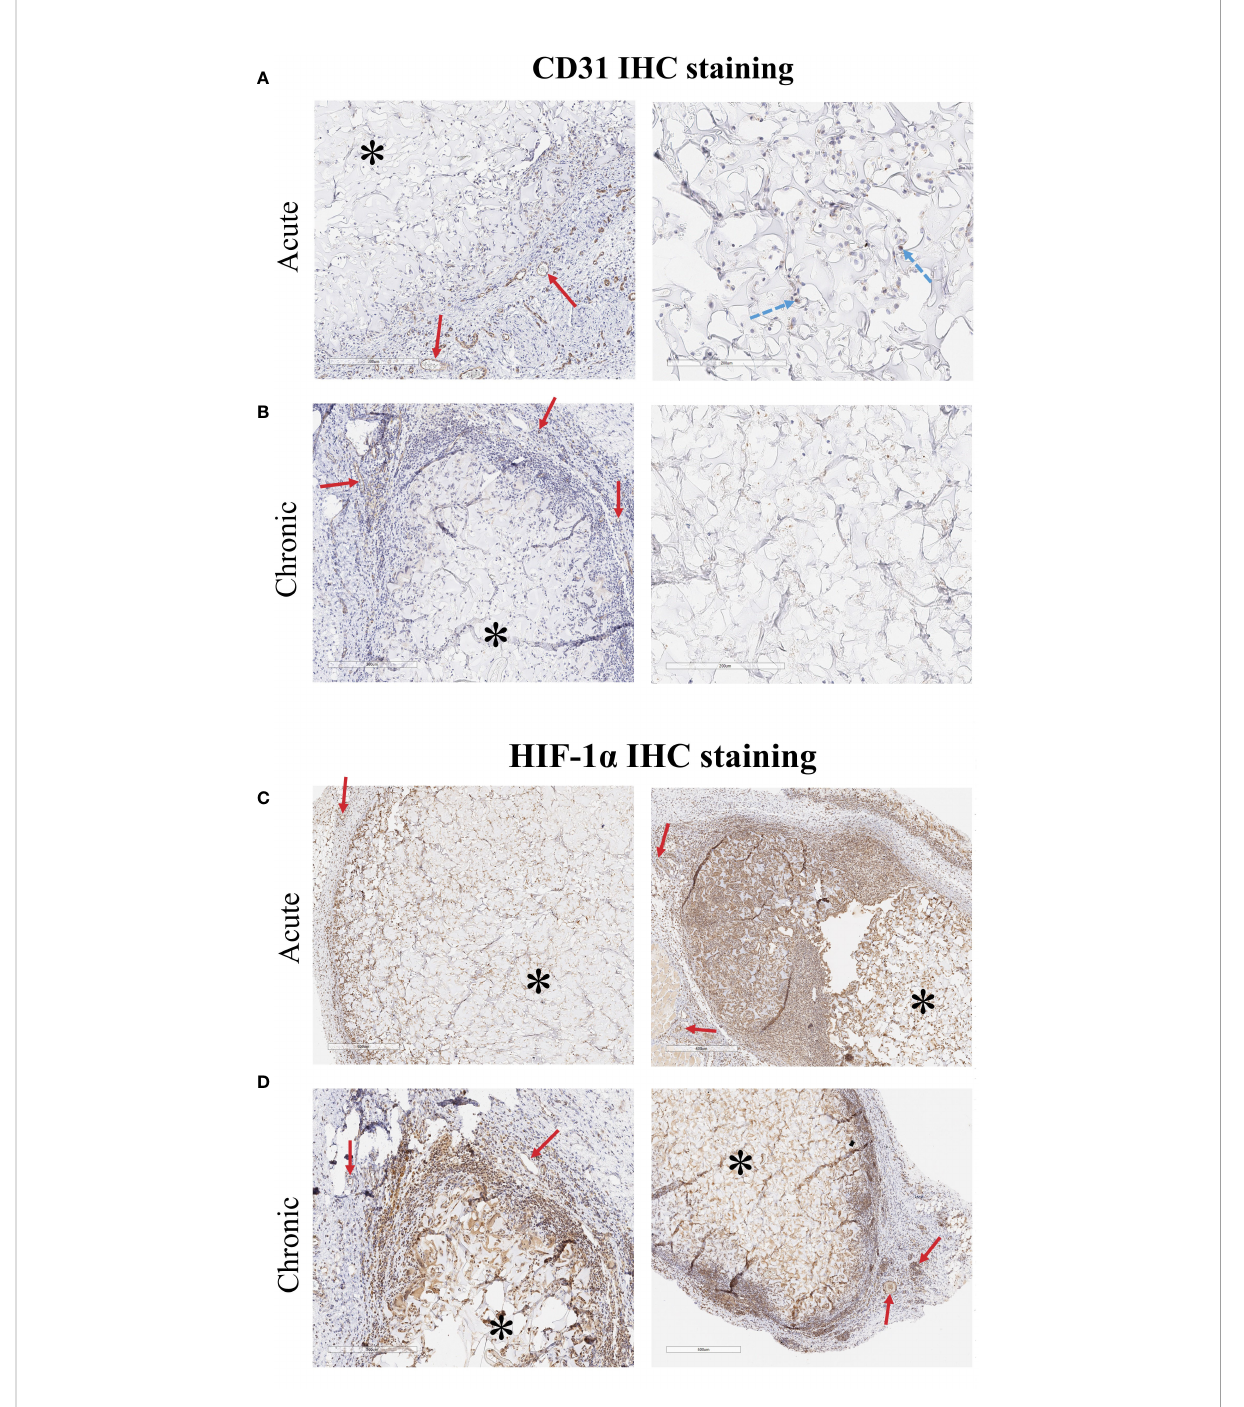
FIGURE 7 CD31 IHC staining of explanted 3D cellularized scaffolds. (A) Staining (brown color is CD31+ cells, hematoxylin counterstain) shows that CD31+ ECs were retained in the scaffold for at least 5 days after implant. (B) After 28 days, CD31+ ECs are not detectable in the areas of the scaffold that have not been in fi ltrated by immune cells. Staining shows increased vascularization around both the acute and chronic scaffolds. HIF-1 a IHC staining of explanted 3D cellularized scaffolds. (C, D) HIF-1 a staining (brown color is HIF-1 a + cells, hematoxylin counterstain) shows that implantation of 3D matrices creates a hypoxic region within the tissue. Immune cells that in fi ltrated into the scaffold also stain positive for HIF- 1 a . Vessels stained for HIF-1 a due to the pathway ’ s role in angiogenesis. Images from two different rats, representative of six rats per time scale. Stars (*) denote encapsulated scaffolds surrounded by immune cells, solid red arrows ( ! ) point to vessels along the outer edge of the implanted scaffold, dashed blue arrows ( ! ) point to ECs embedding within the